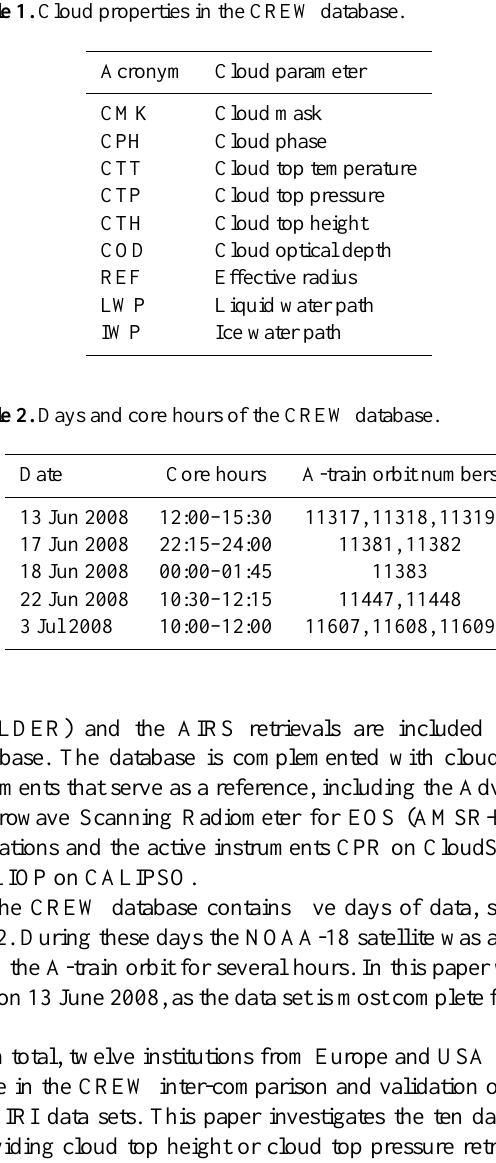
Table 1. Cloud properties in the CREW database.